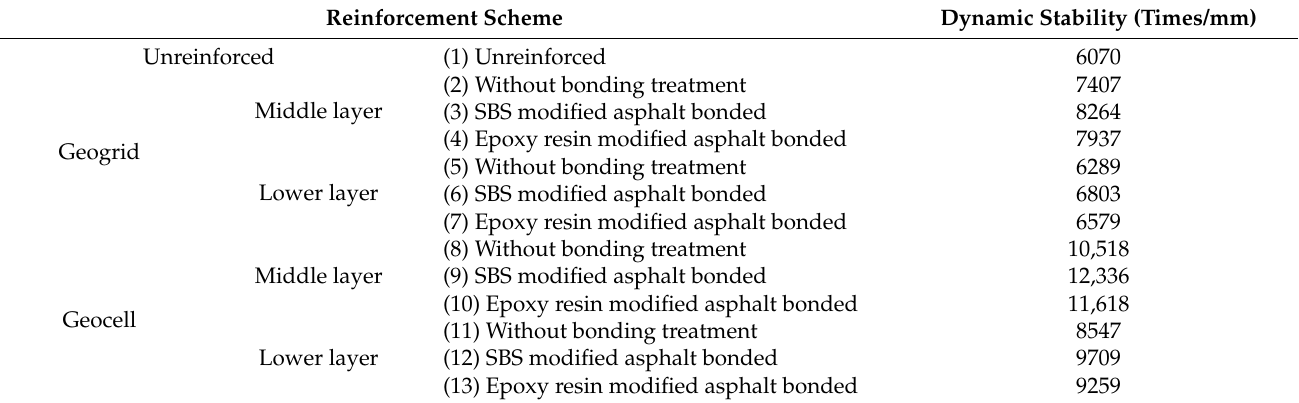
Table 5. Rutting depth and dynamic stability under different reinforcement schemes.